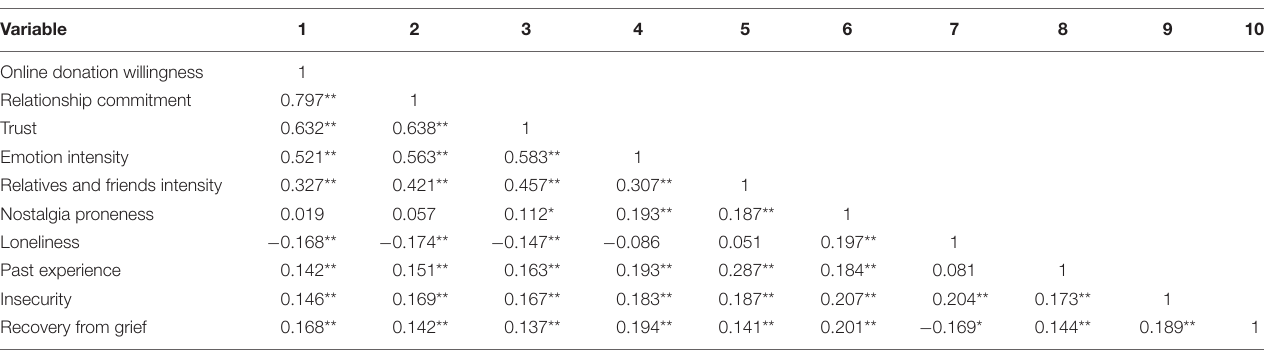
TABLE 3 | Correlations among latent constructs.